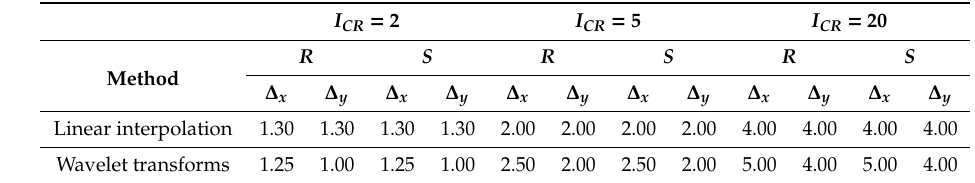
Figure 11. Points 1, 2, and 3 location in the input image plane x , y and their translation in the compressed image plane, ∆ x , y for di ff erent compression methods and ratios. The examples are shown for the bicubic interpolation and STW compression methods. Table 4. Translation of points 1, 2, and 3 locations in the compressed image plane in horizontal ∆ x and vertical ∆ y directions for di ff erent compression methods and